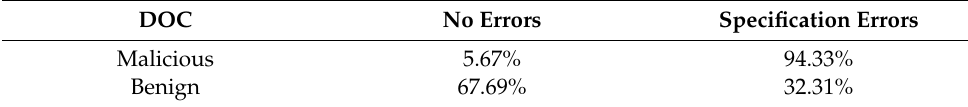
Table 1. The proportion distribution of normative inspections of MS-DOC documents. DOC No Errors Specification